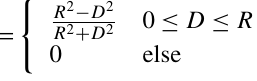
at 1100 m is almost the same for both simulations. The neg- ative wind direction bias represents an anticlockwise devia- and Nhili, 2014) have found similar wind direction biases. A